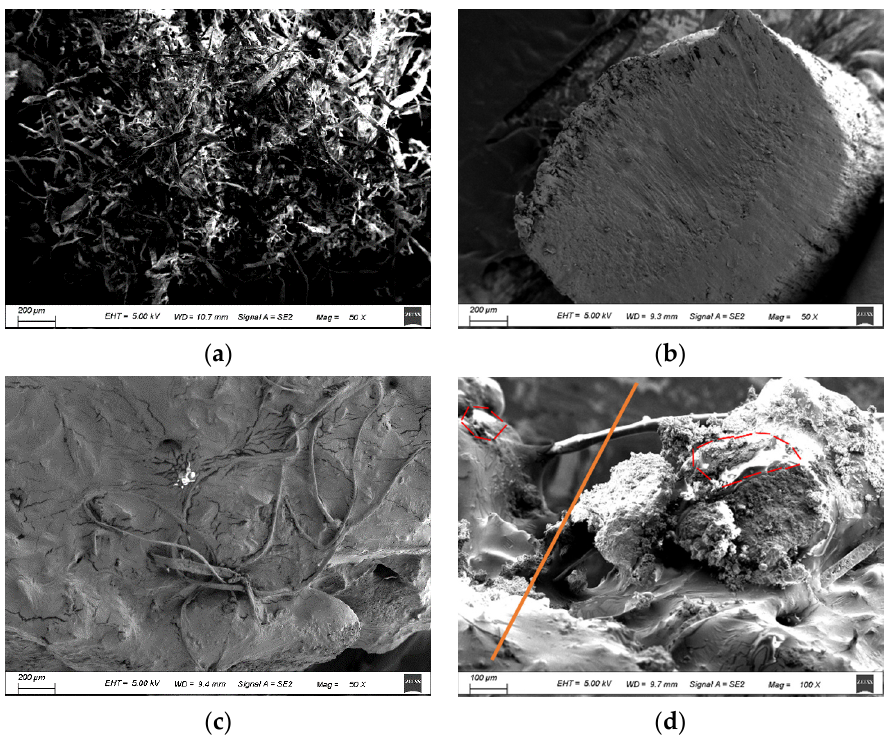
Figure 11. SEM observations result: ( a ) lignin fiber (50×); ( b ) anti-rut agent (50×); ( c ) LF-reinforced mixture with ARA (50×); ( d ) LF-reinforced mixture with ARA (100×).